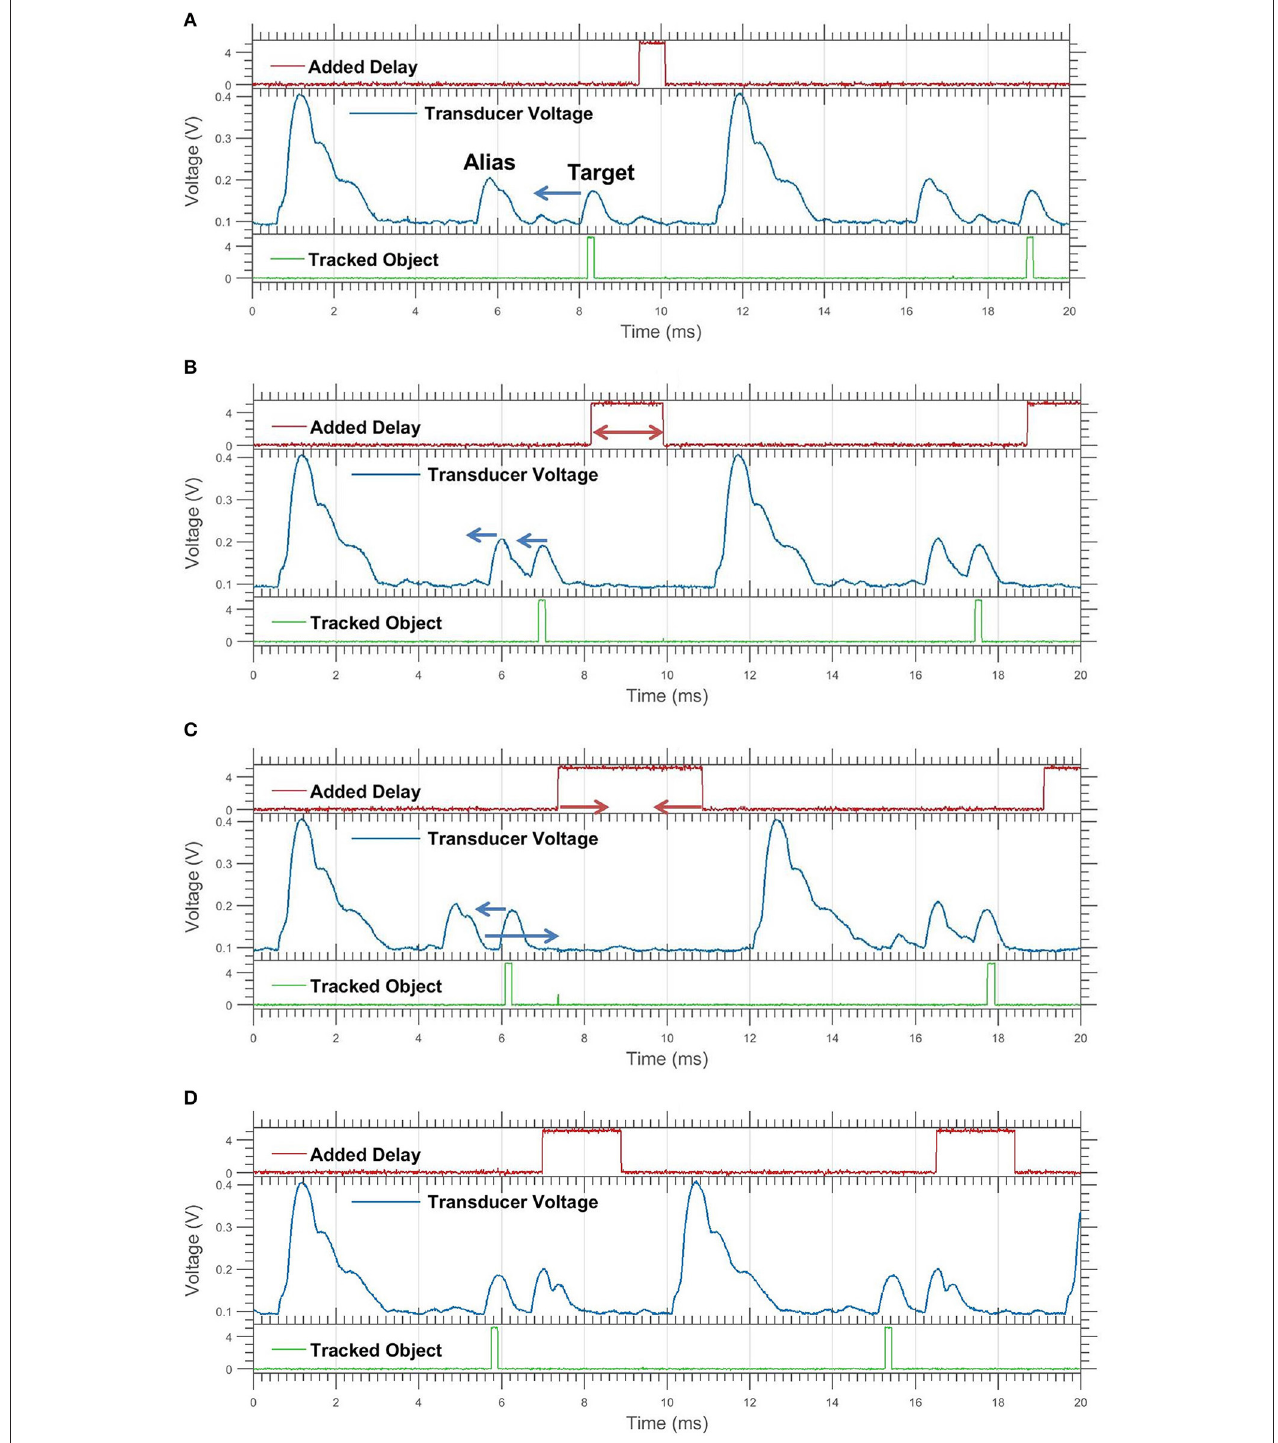
FIGURE 6 | Oscilloscope showing transducer voltage, delay, and tracking for an approaching target . The added delay bit is high when the delay is occurring. The tracking bit is high when receiving the echo of the object being tracked. These graphs are a sequence of events in real time (A–D) . Only two significant objects are present, the target marked by the tracking bit, and the aliased echo. The only object moved was the target; the apparent movement of the alias is due to the delay change. The arrows show movement change for next frame. (A,B) The target moves forward, toward the alias. (B,C) The target continues forward, the alias is pushed forward by the increasing delay. The delay buffer becomes maximized. (C,D) The delay buffer jumps down after reaching its maximum. This causes the alias to “jump” behind the target.